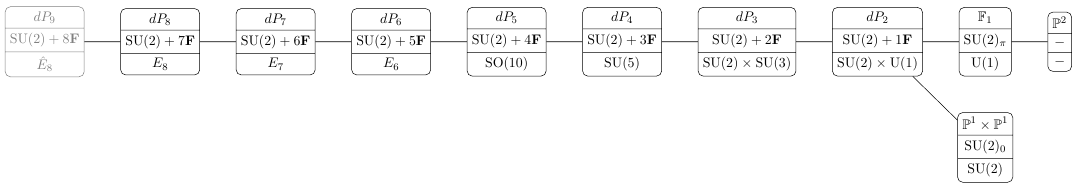
Figure 1 . Rank one 5d SCFTs and E-string theory on S 1 : the associated geometry, the IR e(cid:11)ective gauge theory, and the global symmetry at the conformal